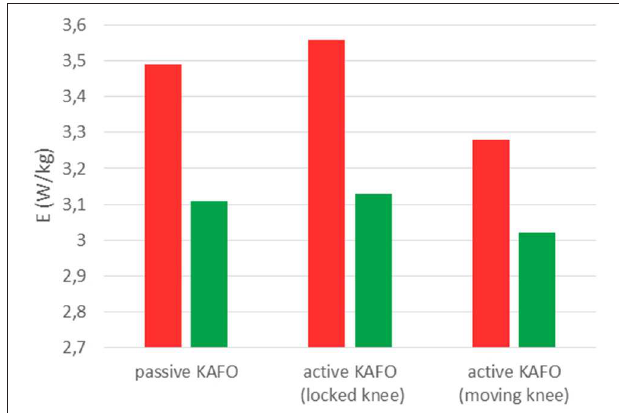
FIGURE 8 | Energy consumptions obtained with Umberger’s model (red) and Bhargava’s model (green) for the SCI subject wearing the three gait-assistive